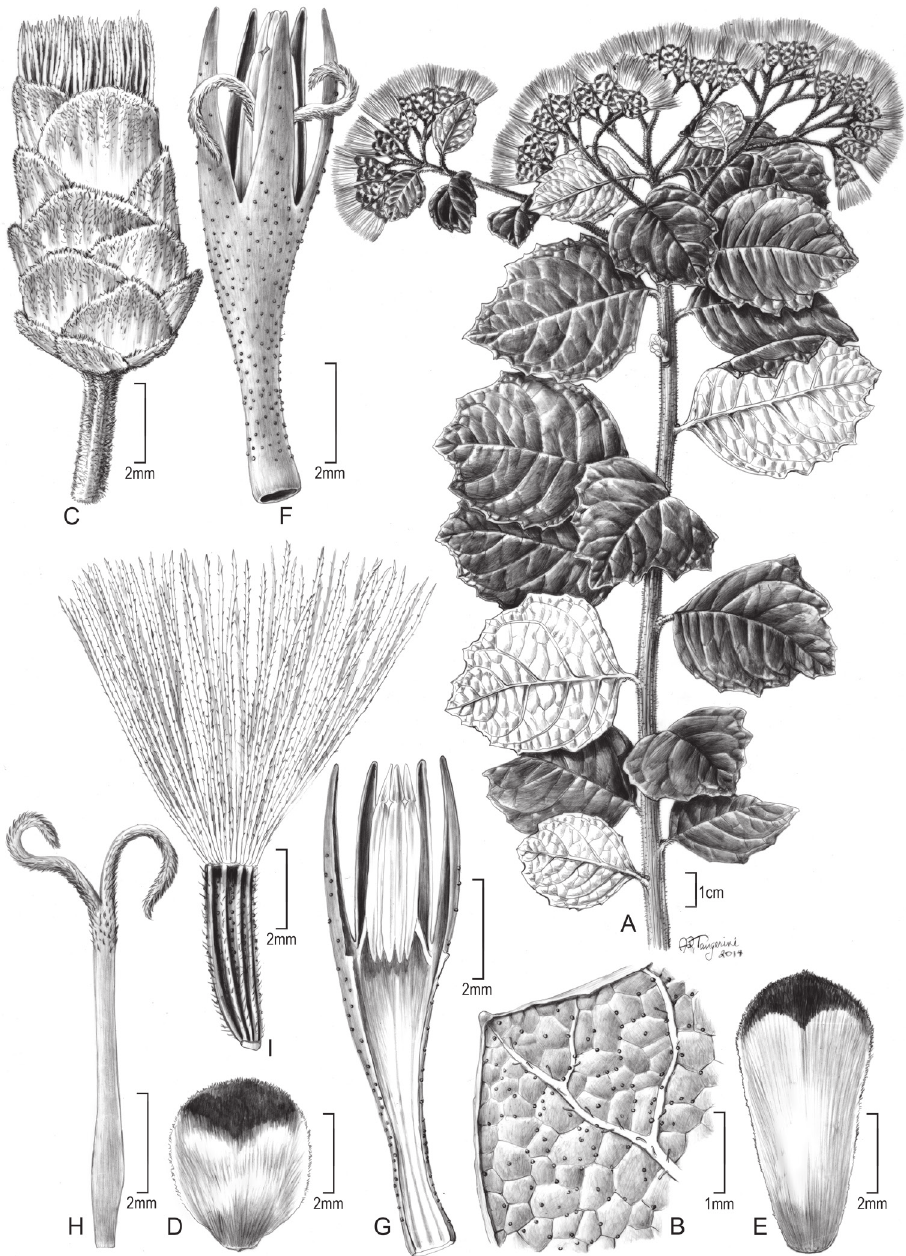
Figure 2. Original Illustration of Gymnanthemum koekemoerae H. Rob. & V.A. Funk: A Habit B Abaxial surface of leaf C Head D Outer involucral bract E Inner involucral bract F Floret G Longitudinal section of floret showing anthers H Style I Achene with pappus. [Illustration by Alice Tangerini